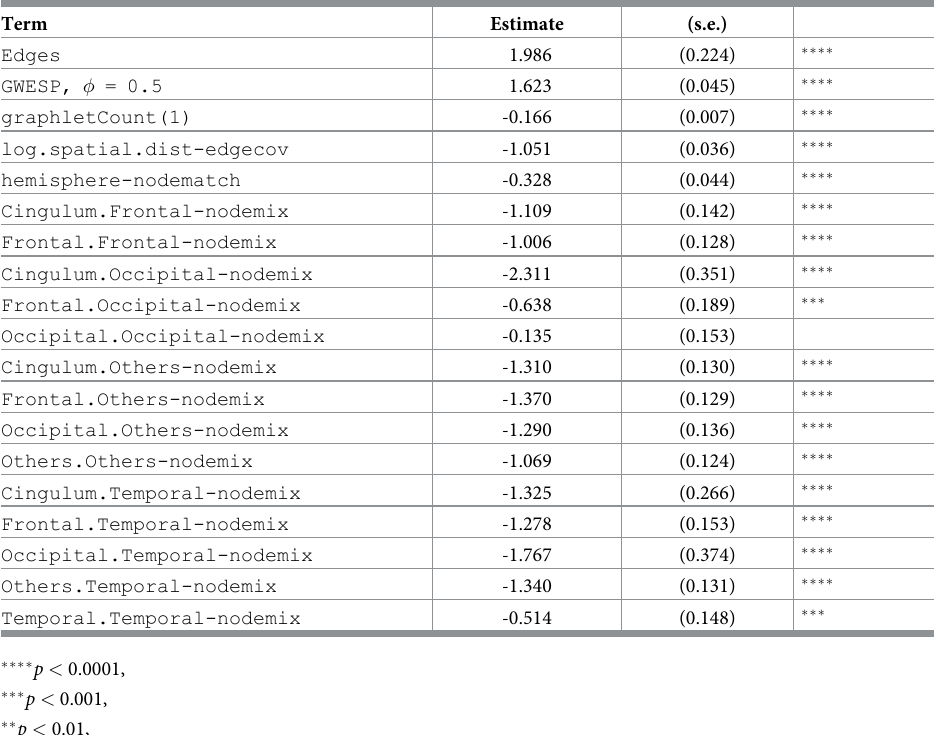
Table 8. Model parameter estimates and standard errors for regularized inference on M